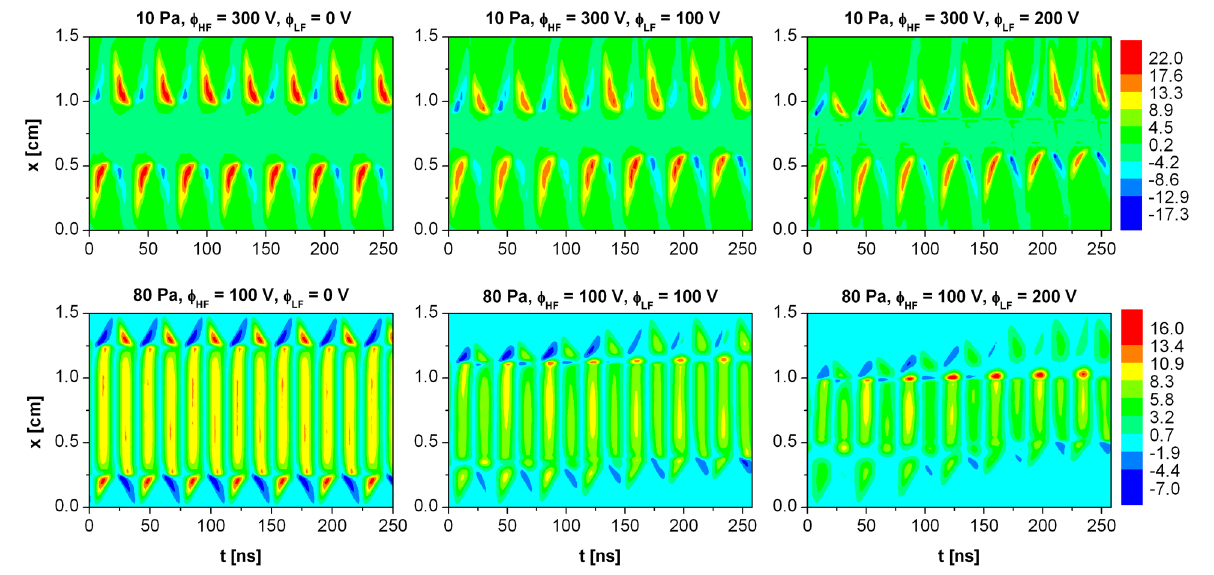
Figure 1 : Spatio-temporal distribution of the electron heating rate in classical dual-frequency discharges operated at 1.937 MHz + 27.12 MHz for different values of the low-frequency voltage amplitude, Φ , at 10 Pa (first row) and at 80 Pa (second row). First column: Φ LF column: Φ =100 V. Third column: Φ =200 V. Φ =300 V at 10 Pa. Φ =100 V at 80 Pa. The color scales are given in 10 4 Wm -3 and apply to LF LF HF HF all plots in the same row. The horizontal axis corresponds to half of the LF period. The vertical axis shows the distance from the powered